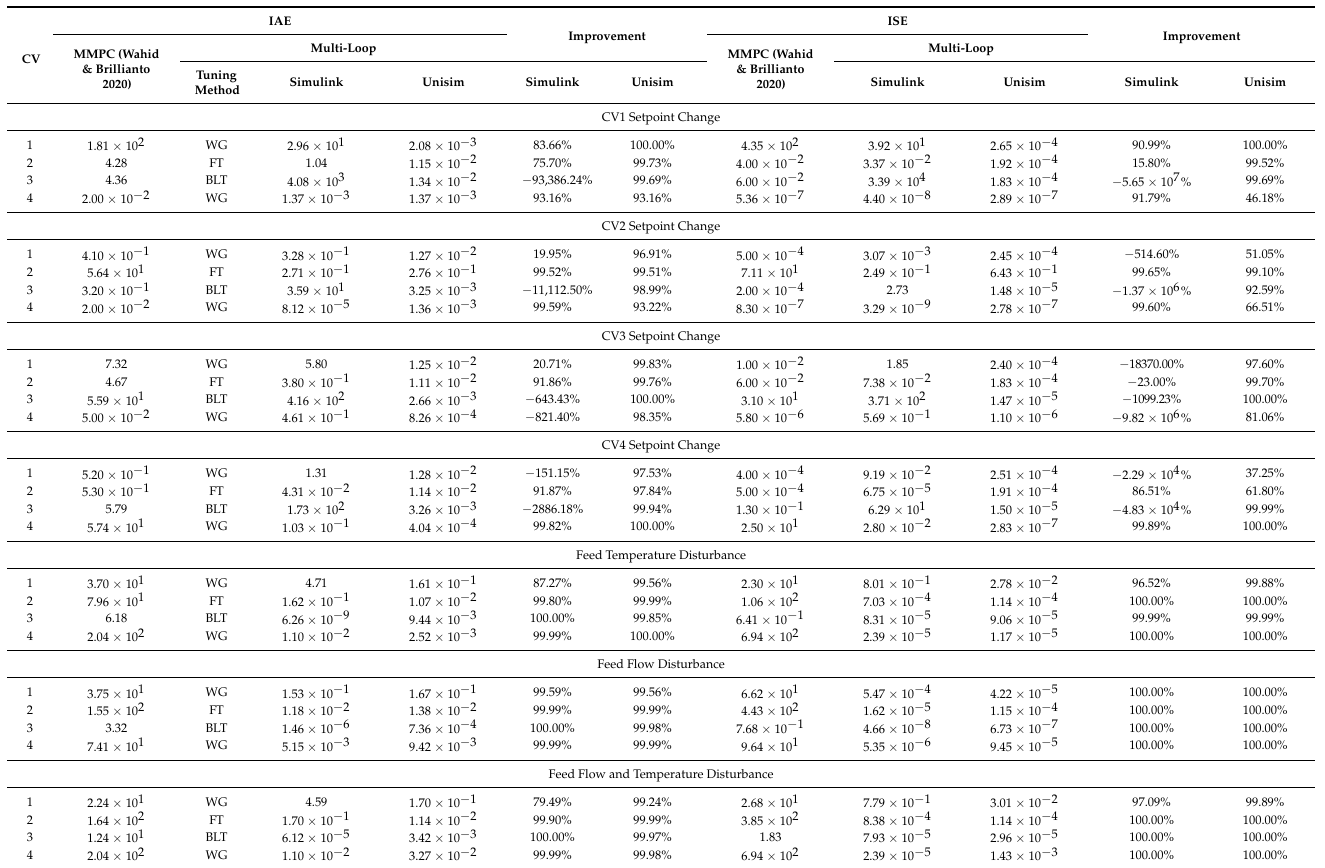
Table 16. IAE comparison of multi-loop PI in Simulink and